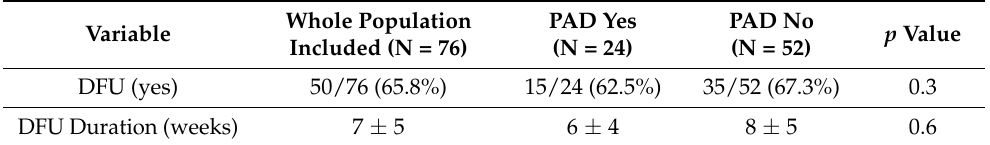
Table 3. Association of ulcer and